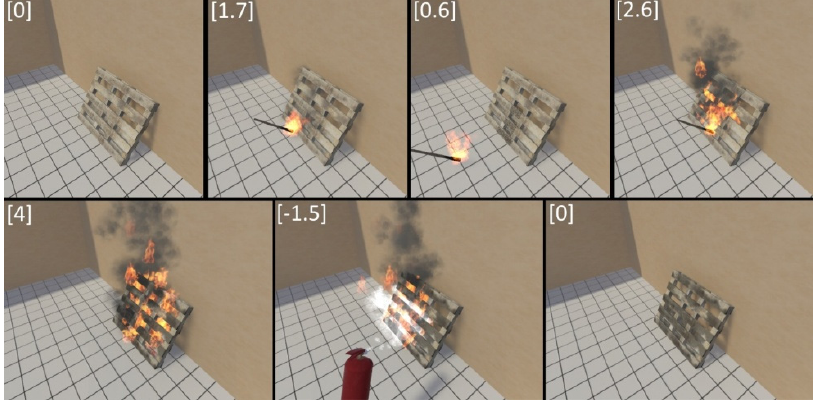
Figure 4. Software implementation of the burning process. Source: developed by the authors in Unity3d.